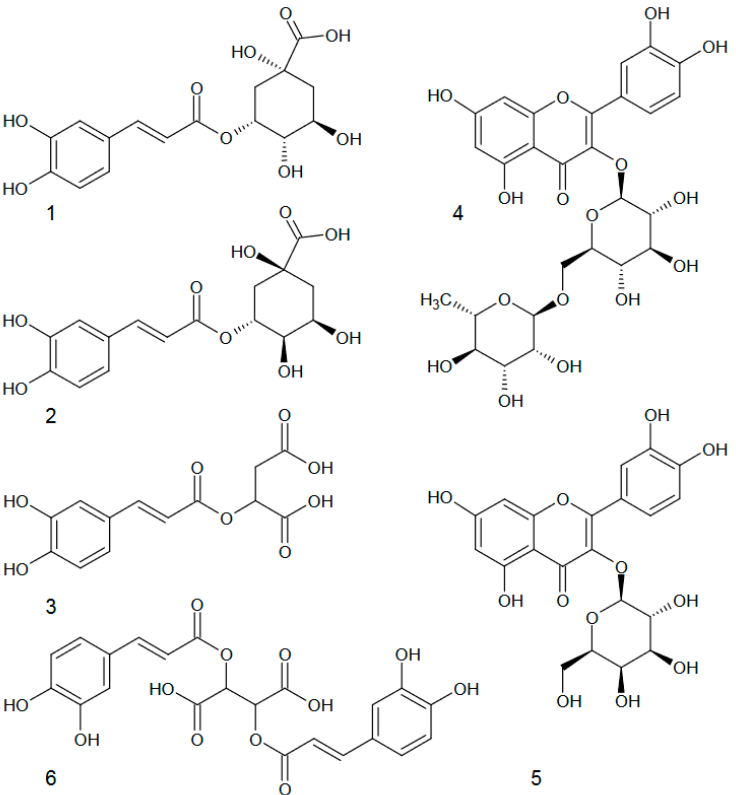
Figure 3. Chemical structures of identified phenolic compounds: ( 1 ) neochlorogenic acid, ( 2 ) chlorogenic acid, ( 3 ) caffeoylmalic acid, ( 4 ) rutoside, ( 5 ) hyperoside and ( 6 ) cichoric acid. As regards diversity within a population, population no. 3 was the most variable in terms of caffeoylmalic acid content (CV = 43.1%), while population no. 4 had the